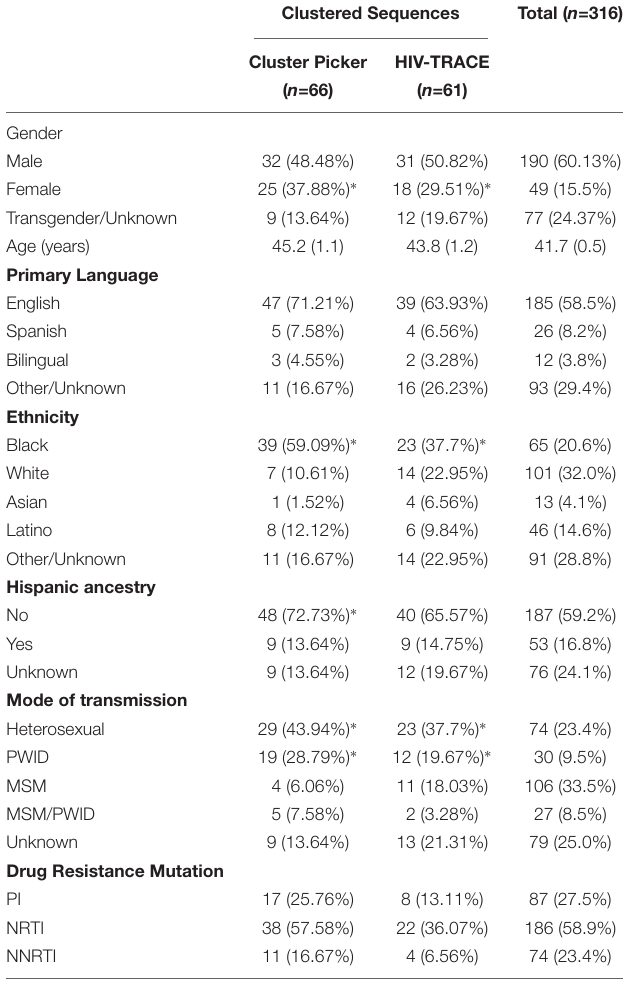
TABLE 1 | Demographic and epidemiological data for 316 HIV-positive adults receiving antiretroviral treatment in San Mateo County, California. Clustered